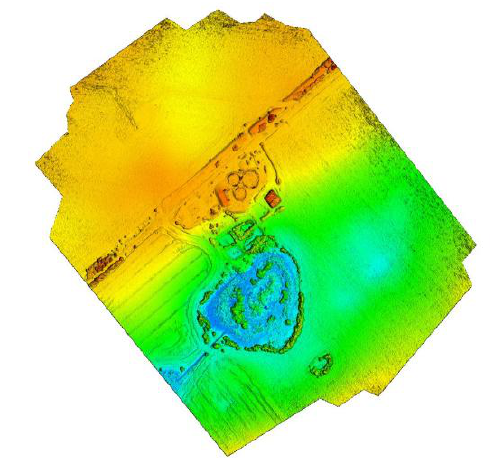
Figure 15 Hybrid Power-Plant, Prenzlau, Germany